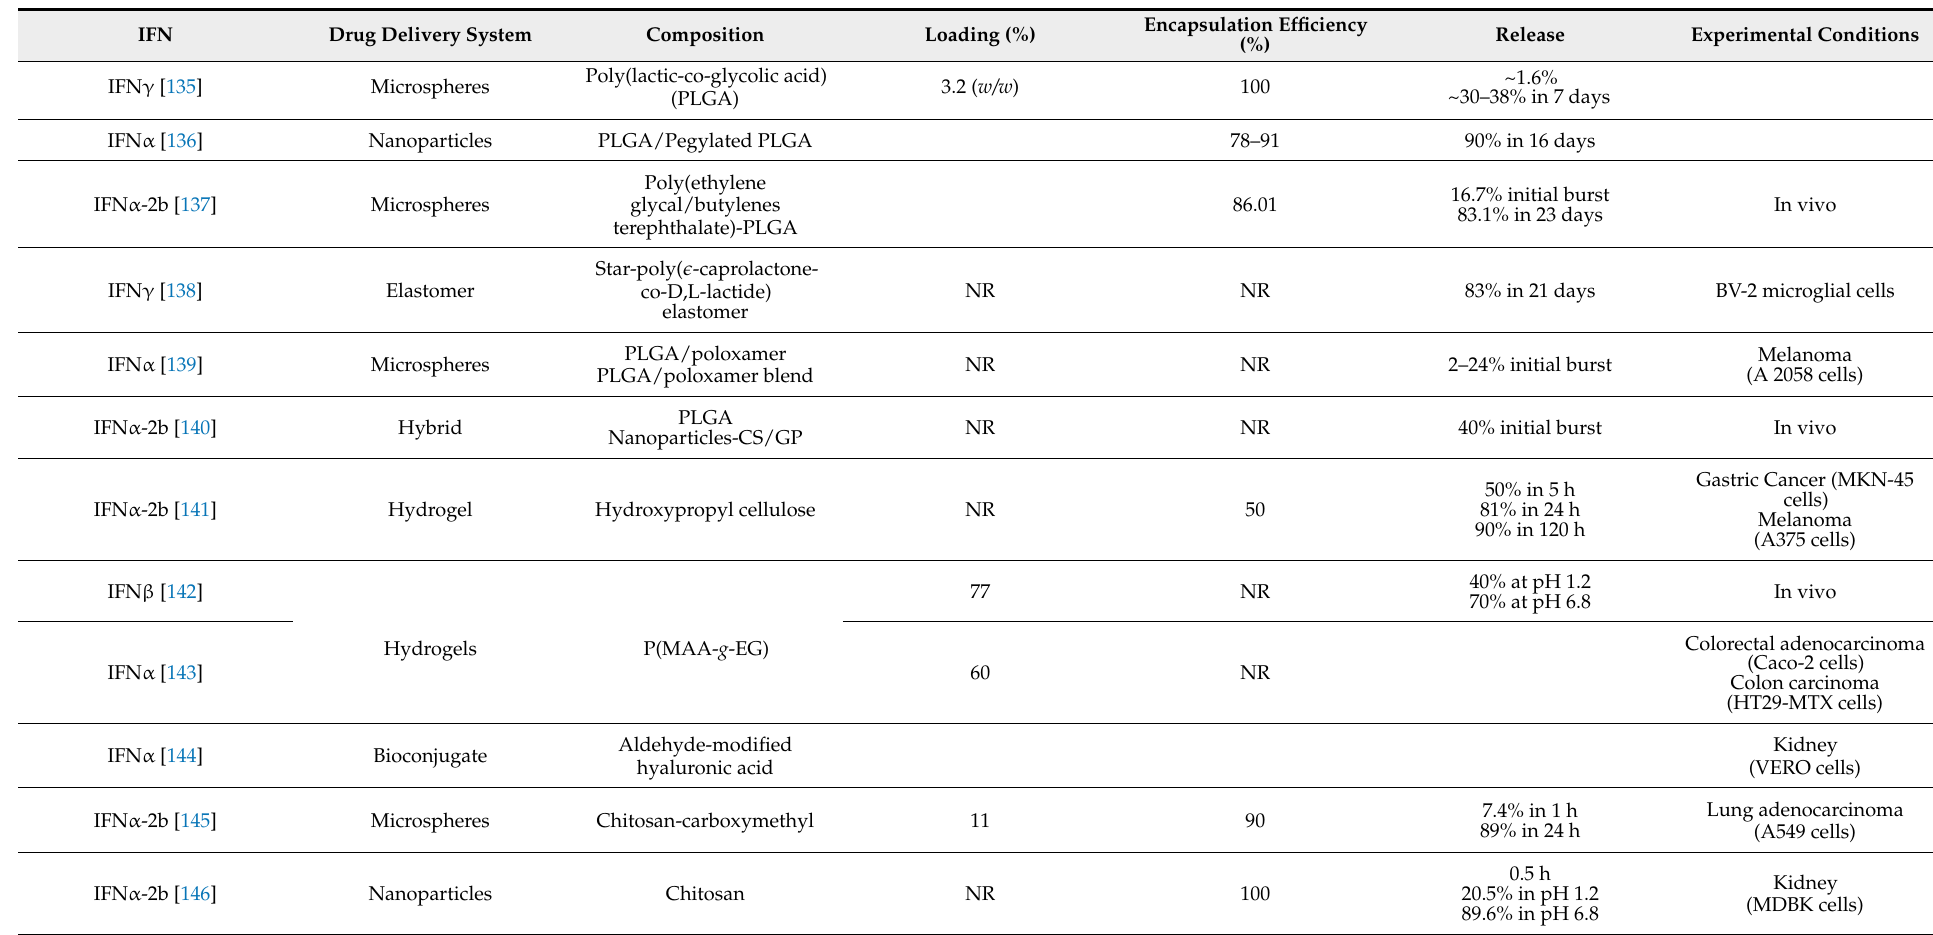
Table 7. Representative studies of IFN drug delivery systems (NR–Not